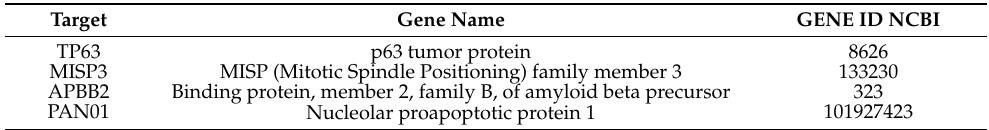
Table 8. Targets of